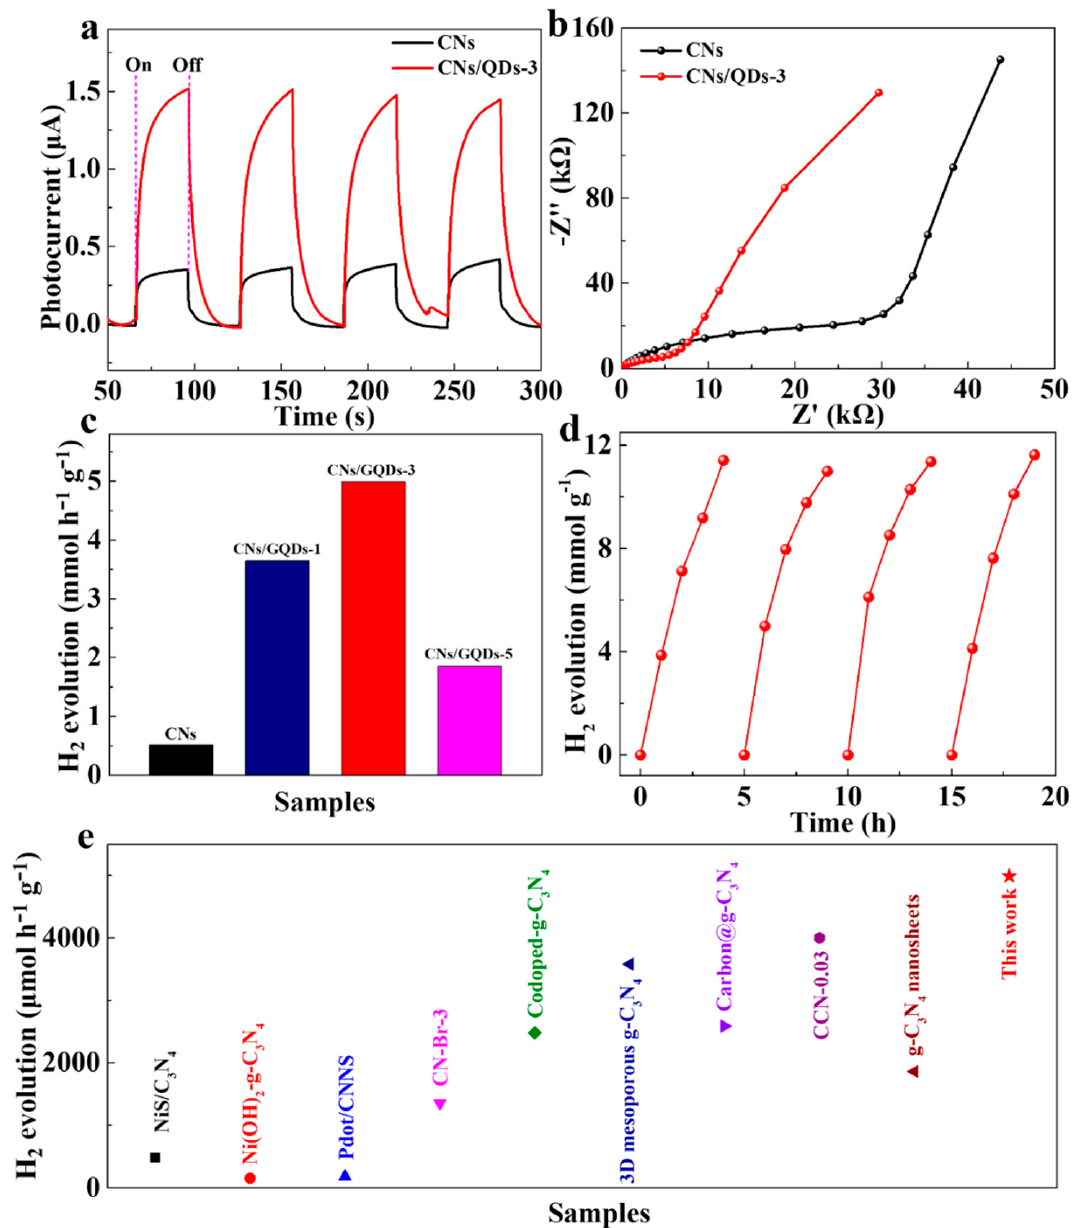
Figure 4. The photoelectrochemical (PEC) properties of CNs and CNs/GQDs-3. ( a ) Photocurrent and ( b ) electrochemical impedance spectroscopy (EIS) curves; ( c ) The H 2 production rate of CNs and CNs/GQDs with Pt assistance ( λ > 420 nm); ( d ) Cycling test curve of CNs/GQDs-3; ( e ) Hydrogen production capacity of CN-based catalysts